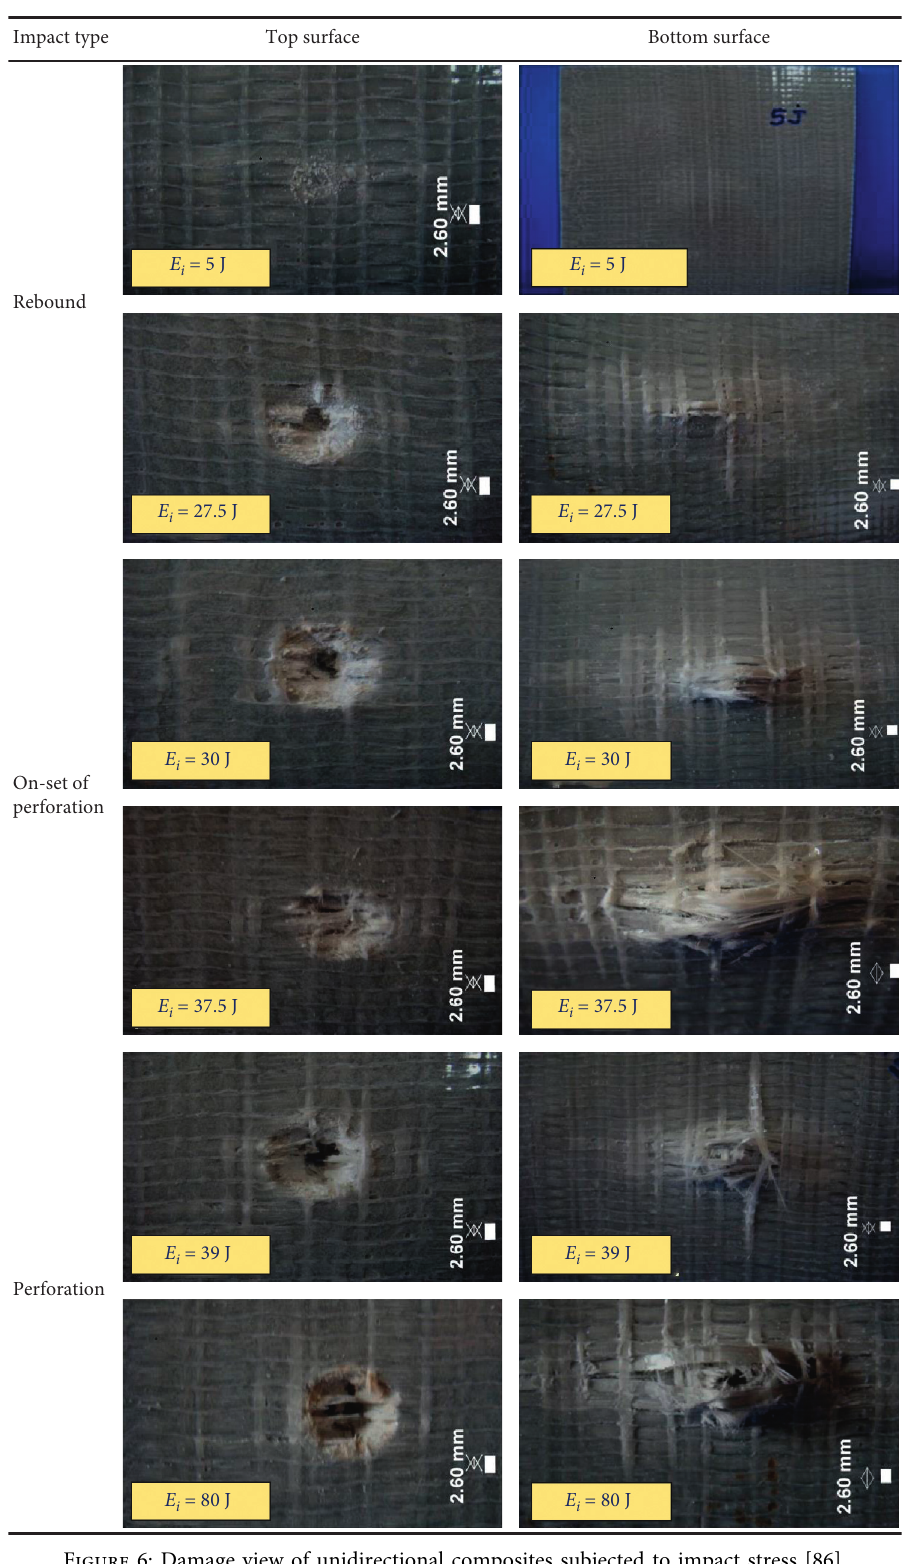
Figure 6: Damage view of unidirectional composites subjected to impact stress